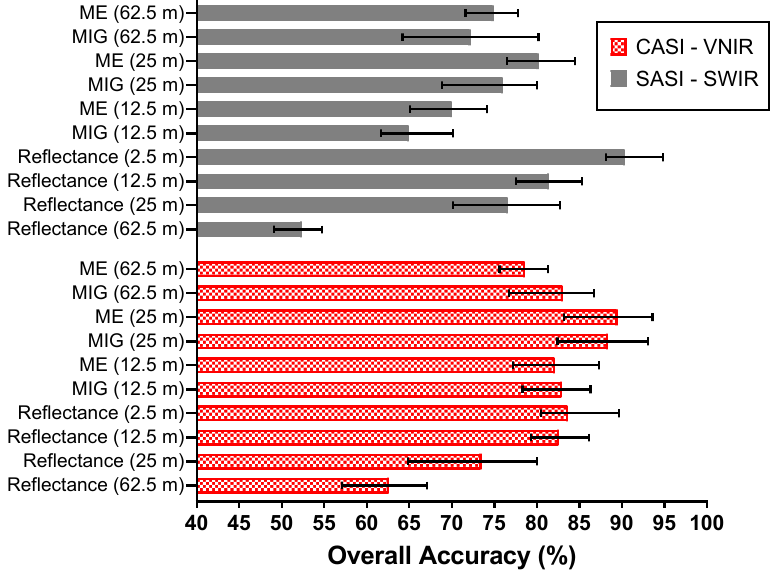
Figure 14. A comparison of the mean classification accuracies for different window sizes 62.5 m, 25 m, and 12.5 m of reflectance data and SCM. The error bars illustrate the minimum and maximum overall classification accuracy achieved for each dataset.